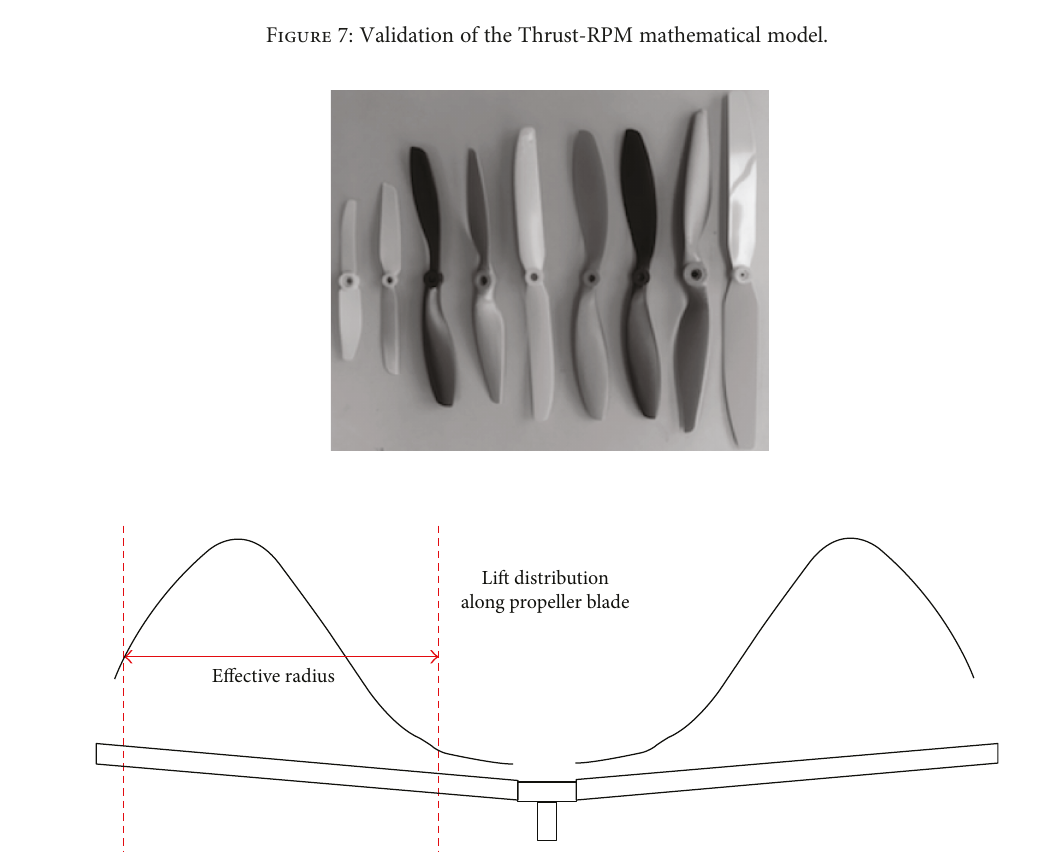
Figure 8: Reference propellers.